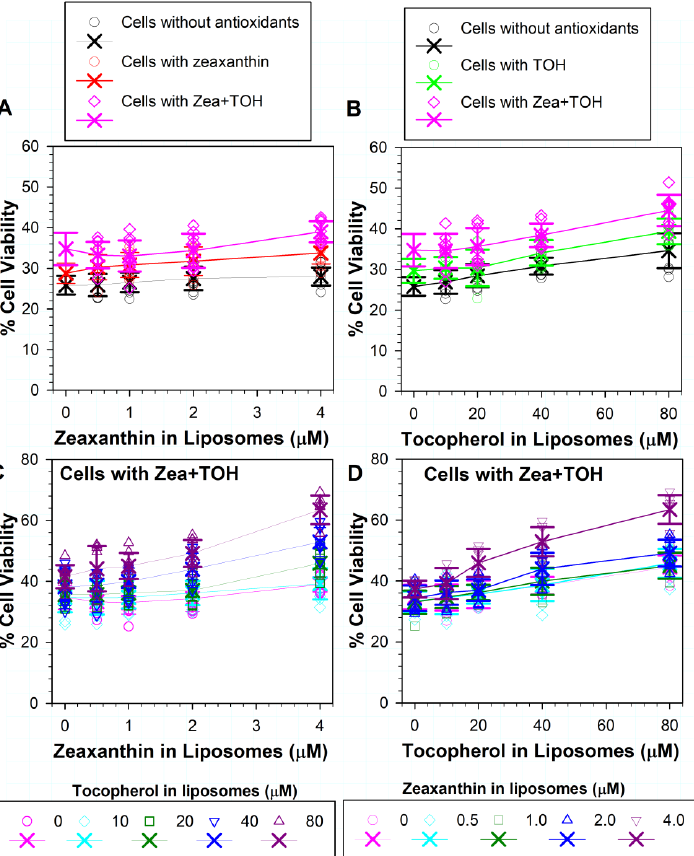
Figure 6. ( A ) Effects of different concentrations of zeaxanthin in liposomes on phototoxicity to ARPE- 19 cells not supplemented with antioxidants, supplemented with zeaxanthin, or supplemented with a combination of α -tocopherol with zeaxanthin (Zea + TOH). ( B ) Effects of different concentrations of α -tocopherol (TOH) in liposomes on phototoxicity to ARPE-19 cells not supplemented with antioxidants, supplemented with α -tocopherol or supplemented with a combination of α -tocopherol with zeaxanthin (Zea + TOH). ( C ) Effects on phototoxicity of different combinations of zeaxanthin and α -tocopherol in liposomes to ARPE-19 cells supplemented with α -tocopherol and zeaxanthin. ( D ) The data are the same as in Figure 6C plotted as a function of α -tocopherol concentration. The symbols represent the viability of cells in independent experiments, the crosses represent the means, while the error bars show SDs (the individual data points from experiments with no antioxidants in liposomes are shown only in Figure 3; N for each experiment with antioxidants in liposomes was 8). Other experimental conditions as in Figure